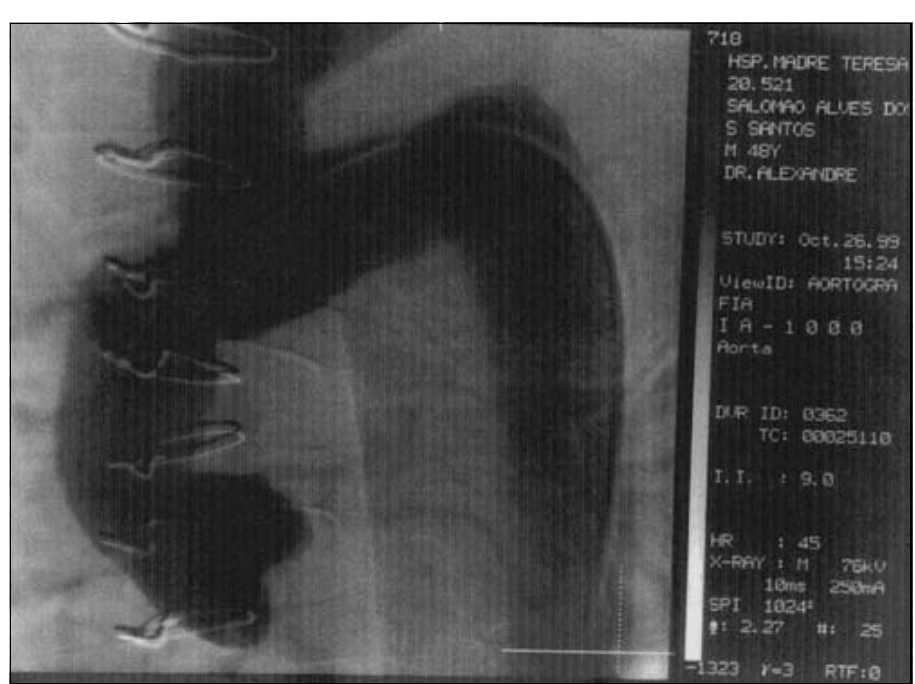
Fig. 2 - Aortografia p(cid:243)s-operat(cid:243)ria do mesmo caso.